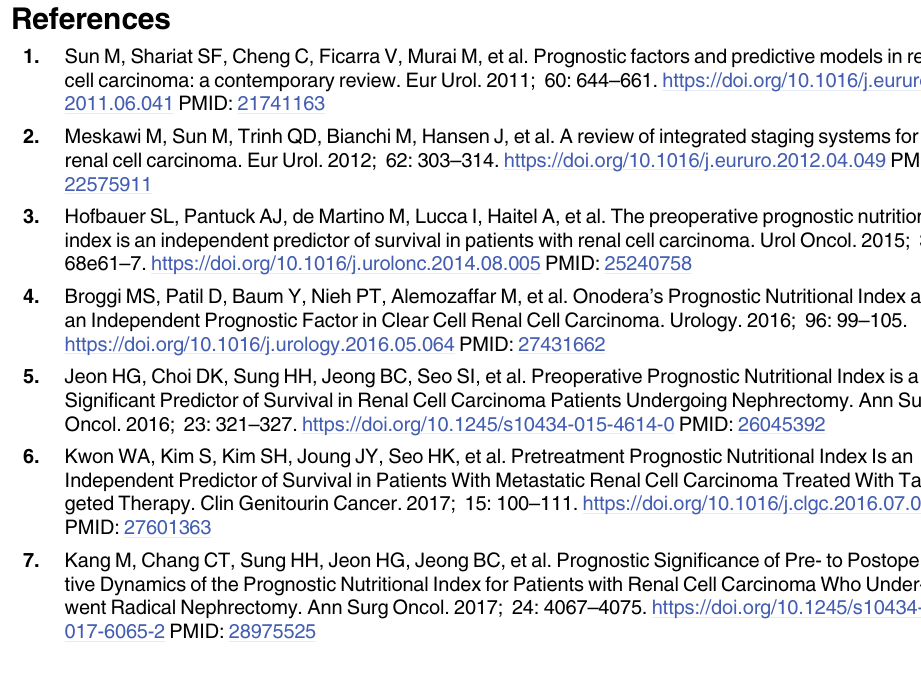
S1 Fig. Deeks’ funnel plot for asymmetry test for detecting publication